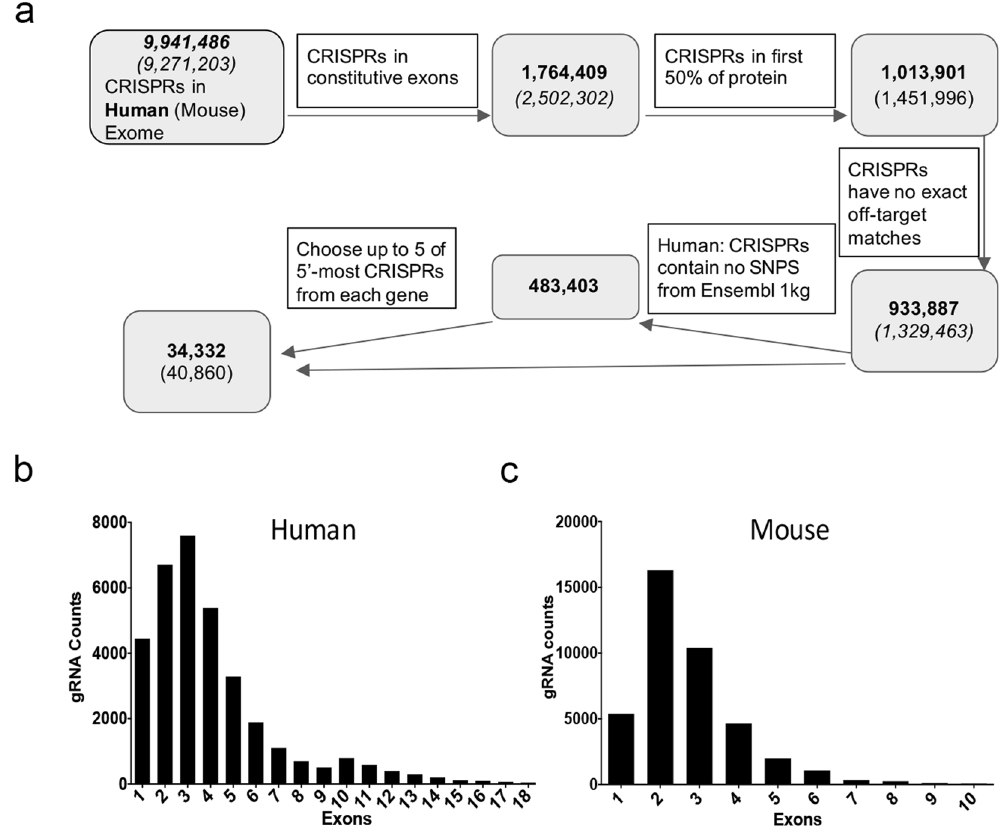
Figure 3. Human and mouse sgRNA arrayed library design. ( a ) Schematic illustrating sgRNA genome wide library design work flow. ( b , c ) Graphs illustrating the number of sgRNA designed per gene exon in the human and mouse sgRNA arrayed libraries.